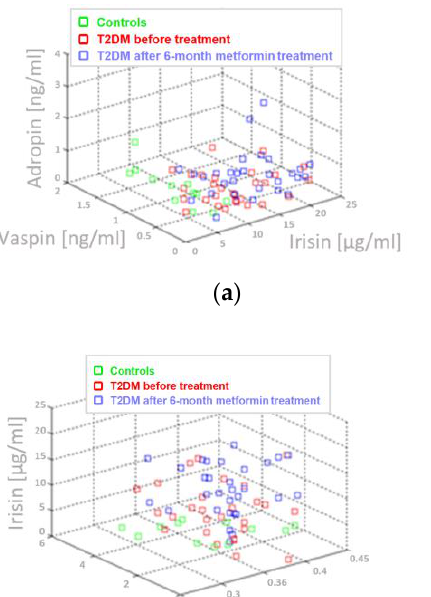
Figure 1. Three-parameter discriminant analysis, which allow to differentiate subjects with metabolically healthy obesity and T2DM obese patients: ( a ) Adropin, irisin and vaspin data set obtained from all examined individuals ( b ) Graph of the discriminatory curve which based on adropin, irisin and vaspin allows for separation between healthy obesity and T2DM patients with ACC = 94 [%] ( c ) Irisin, QIUCKI, and HOMA-IR data set obtained from all examined individuals ( d ) Graph of the discriminatory curve which based on irisin, QIUCKI and HOMA-IR allows for separation between healthy obesity and T2DM patients with ACC = 90 [%] .